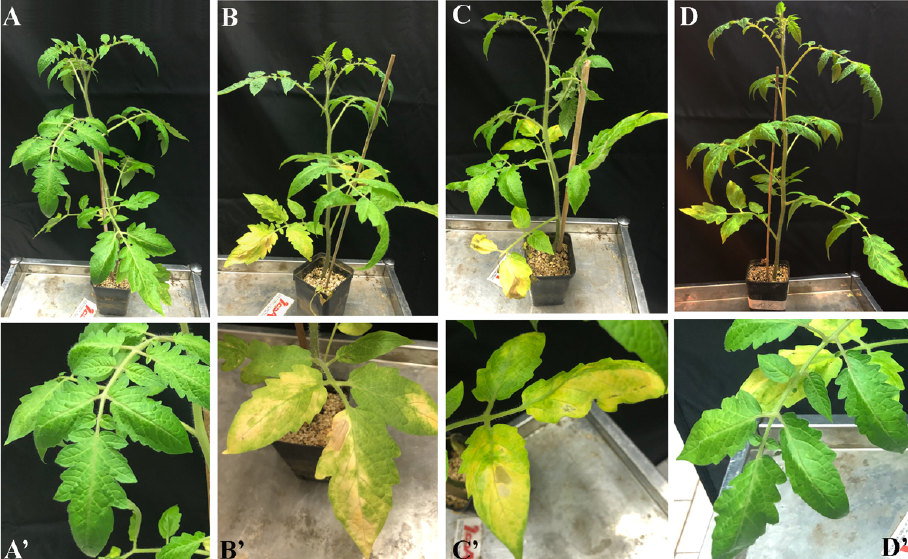
Figure 6. Tomato plants inoculated with V. dahliae for 10 days (( B , B’ ) Positive CTR) and treated with OLE ‐ loaded CTNPs for 7 days at ( C , C’ ): 0.71 mg/mL, ( D , D’ ): 1.41 mg/mL, ( A , A’ ) non ‐ inoculated tomato plants (negative CTR).